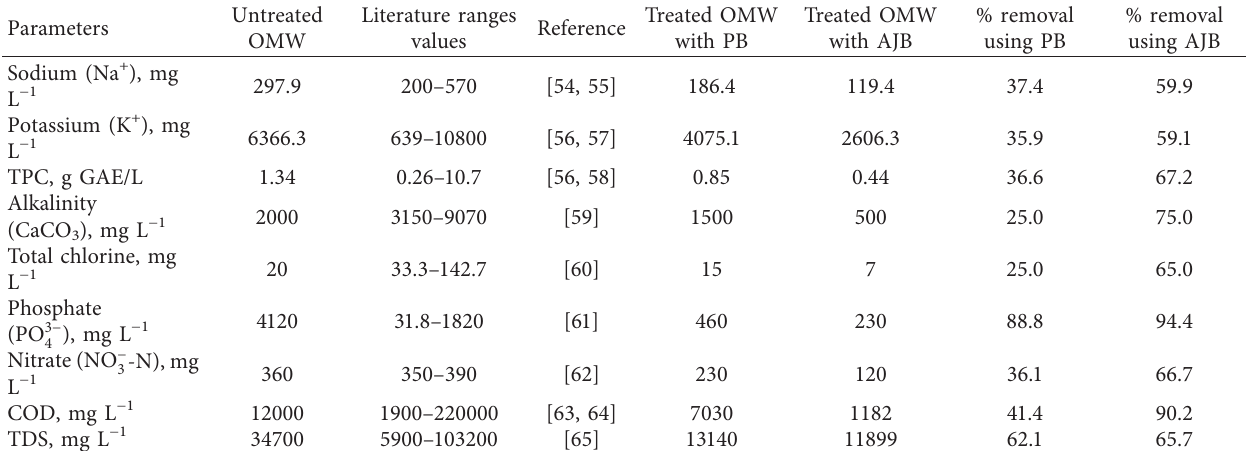
Figure 4: TGA curves of PB and AJB. Table 1: Main characteristics of the OMW sample untreated and treated with PB and